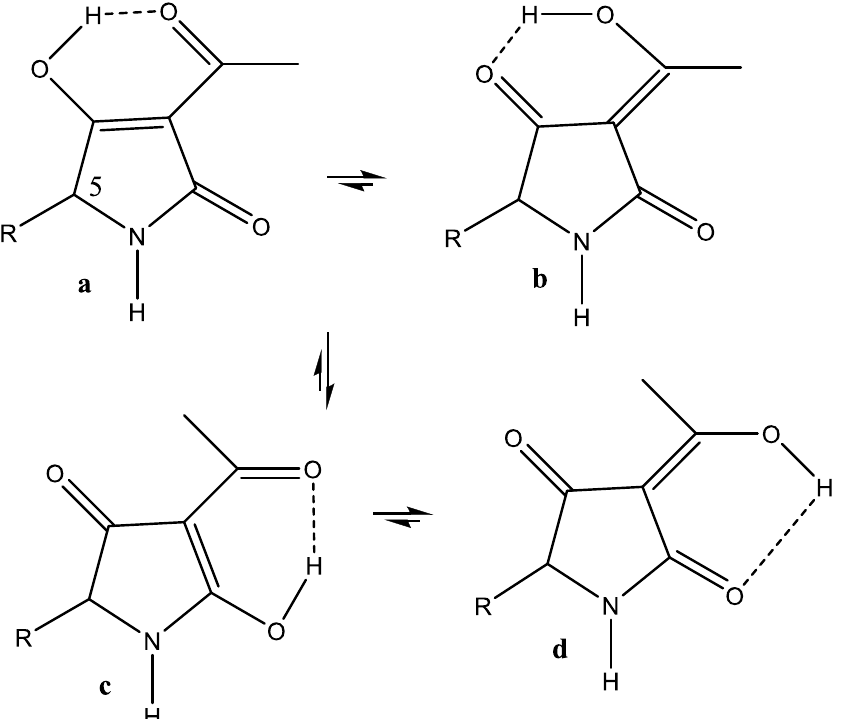
Figure 13. Tautomers of tenuazonic acid, R = isobutyl.